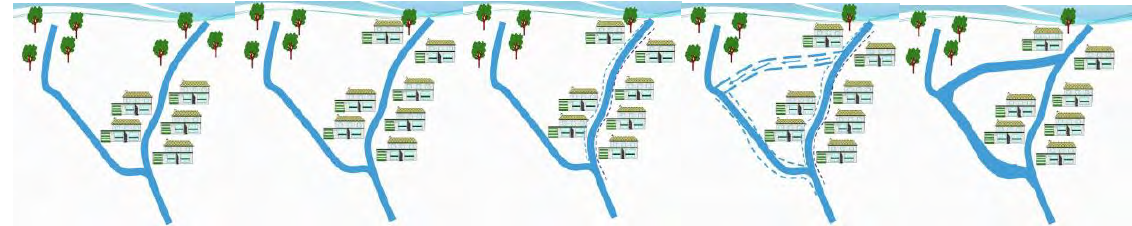
Fig. 25: New Branch steps. (edited by the author, source: Jin, 2019).